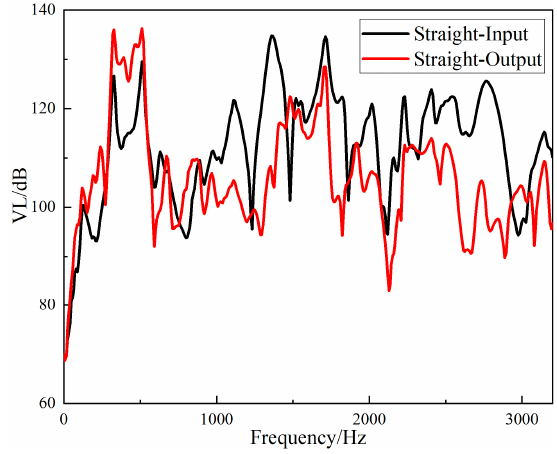
Figure 18. Frequency domain input and output VL Z of the straight-tube structure support.